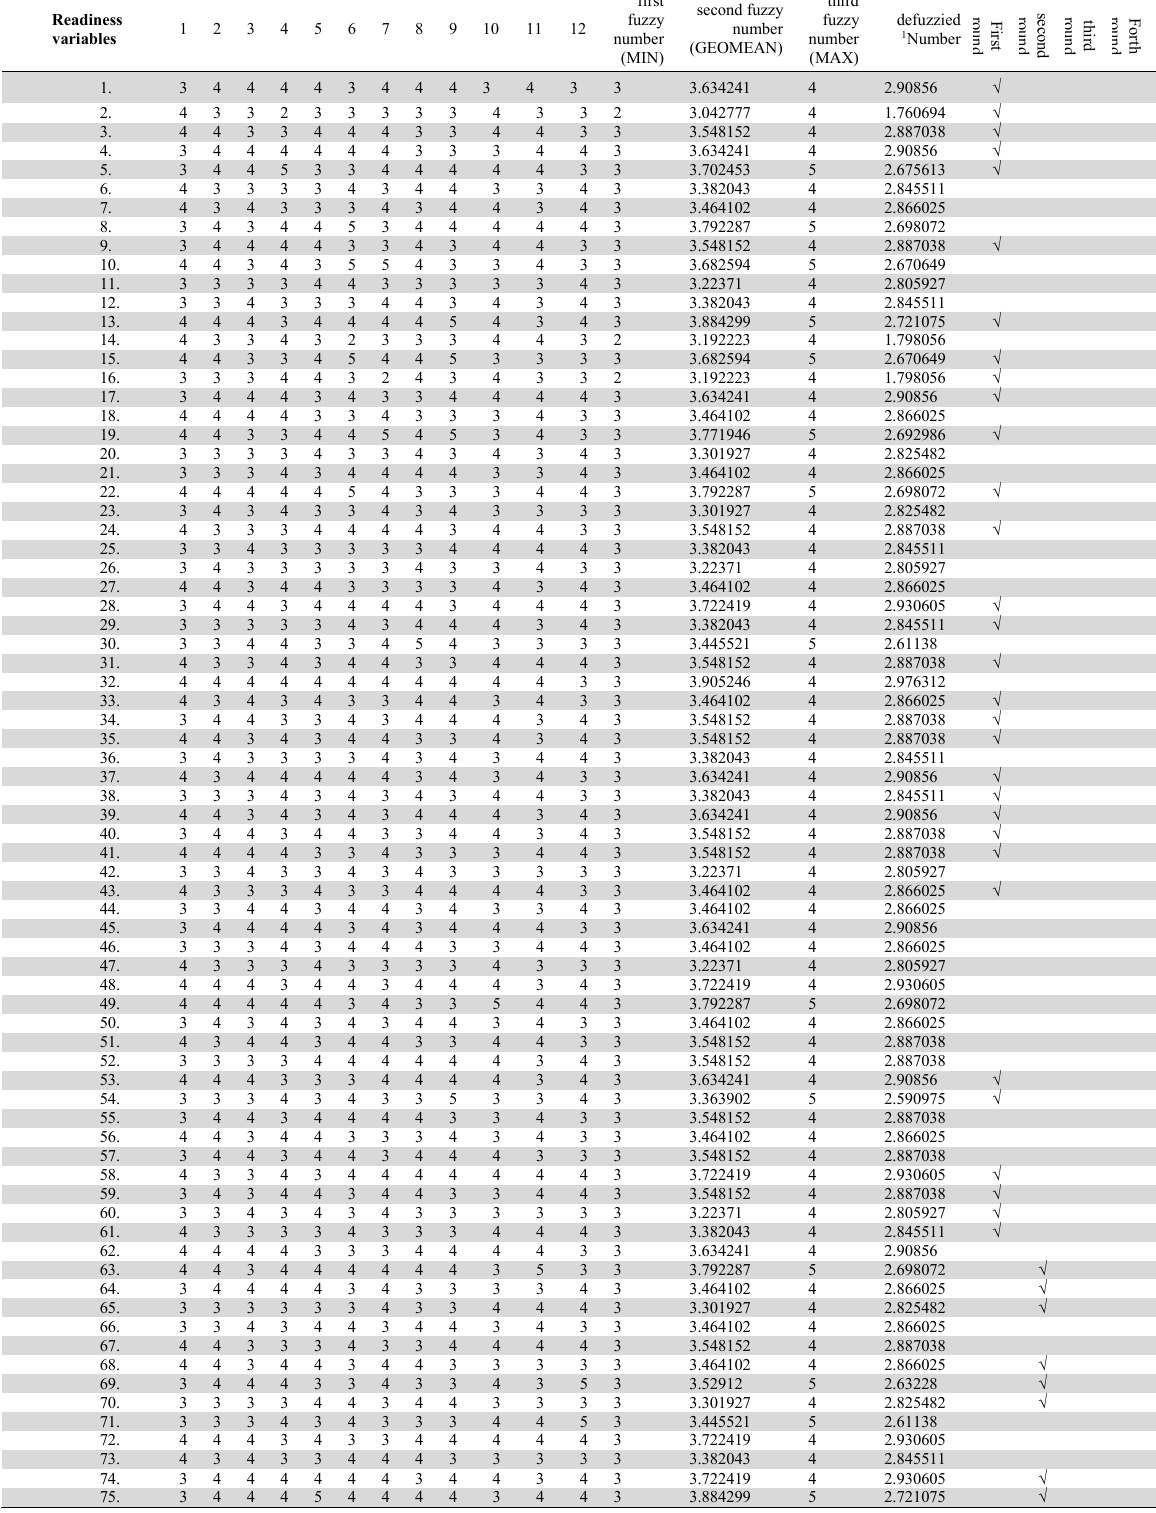
Indicators extracted from the literature & their initial and finalized list Readiness